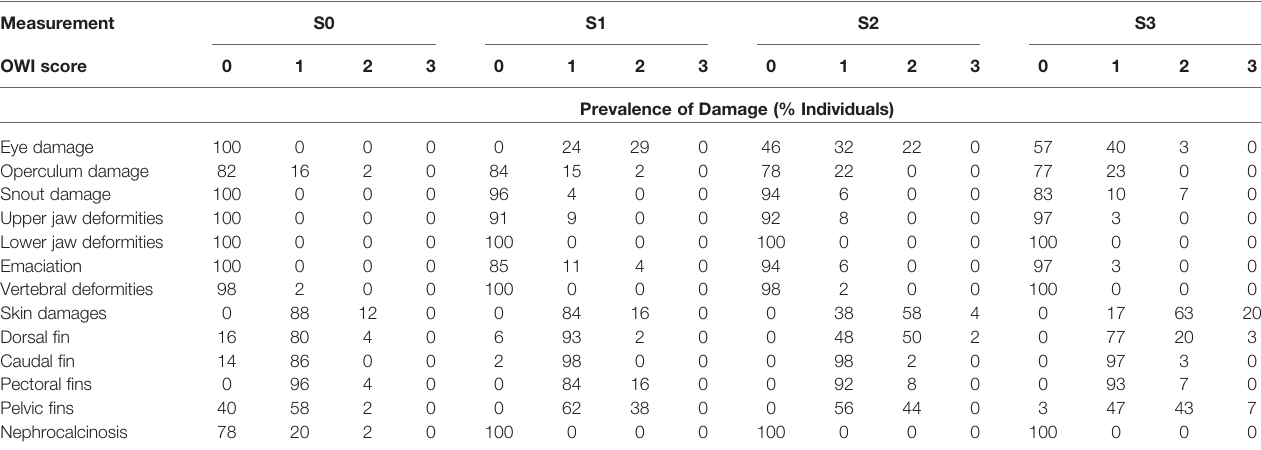
TABLE 3 | Prevalence of damage, deformities, emaciation and nephrocalcinosis (% Individuals), n = 30) of evaluated external morphological operational welfare indicators [OWI, scored from 0 (lowest) to 3 (highest) prevalence] recorded at 3 different time points (T0 = RAS facility, T1 and T2 = FishGLOBE V5, T3 = net pen facility).